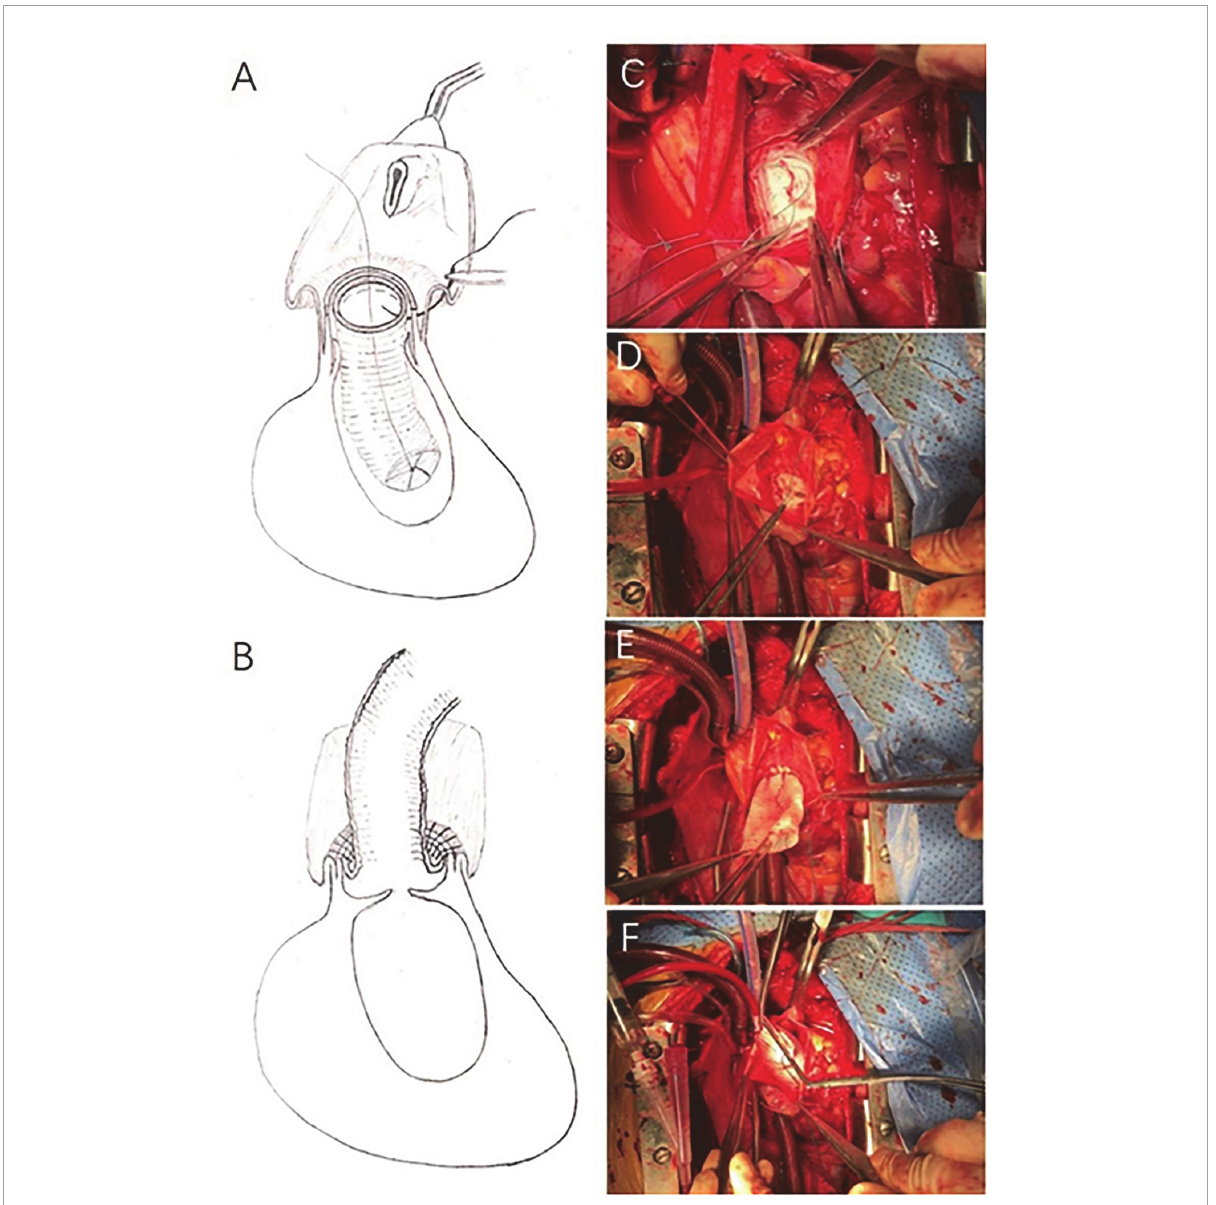
FIGURE2 Adventitial eversion and prosthesis eversion technique for proximal anastomosis. A segment of artificial graft was inverted and inserted into the aortic root (A,C) . During the suture, the adventitia above the suture line was everted to form two layers of adventitia (A). The two layers of adventitia were directly anastomosed to the inverted part of the graft with continuous 4–0 prolene (A) . Thereafter, the rest part of the artificial graft was dragged out of the aortic root (B,D,E) . Afterward, cardioplegia was infused through the artificial graft in order to check any possible bleeding at the anastomosis site and aortic valve function (F)